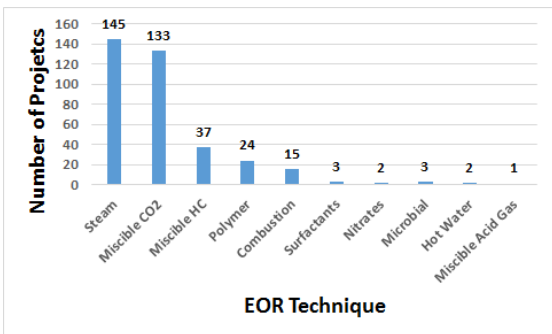
Figure 9. Successful worldwide enhanced oil recovery (EOR) projects. Successful EOR techniques with number of projects less than 15 were not analysed and were excluded in training for training accuracy and efficiency. Data source: [15,38]. Table 2 indicates that oil properties and reservoir characteristics were updated according to the available data set from the worldwide successful EOR projects and is not intended to present threshold limits since the range could be affected also by economic constraints and scientific